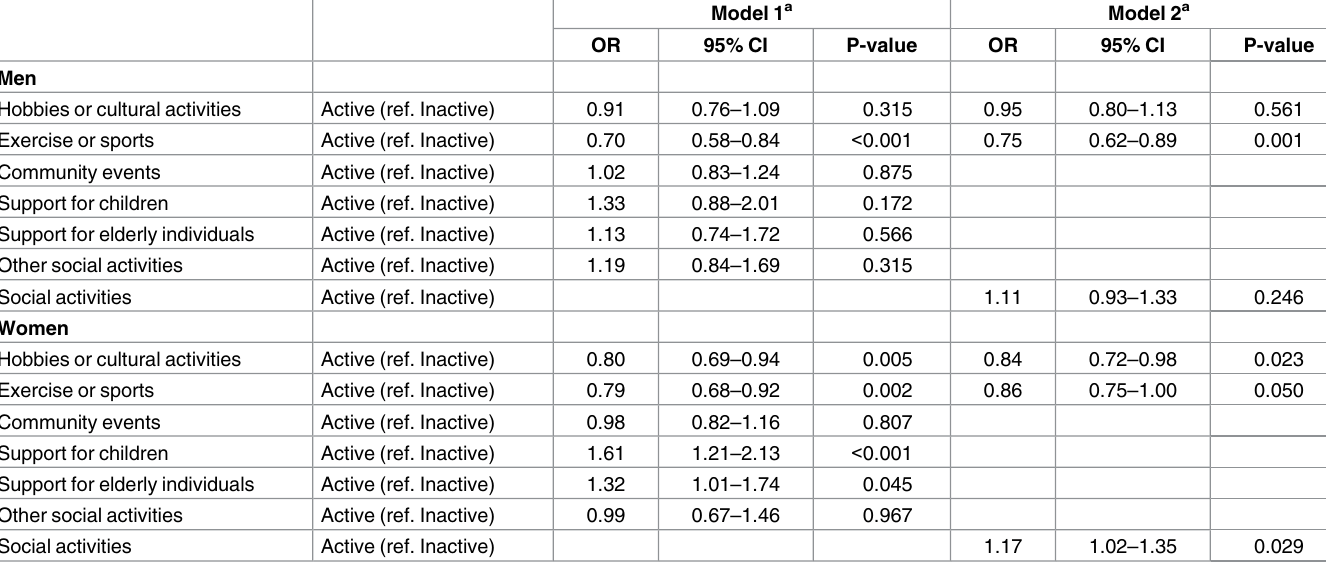
Table 2. Results of multiple logistic regression analyses for the relationships between leisure and social activities and